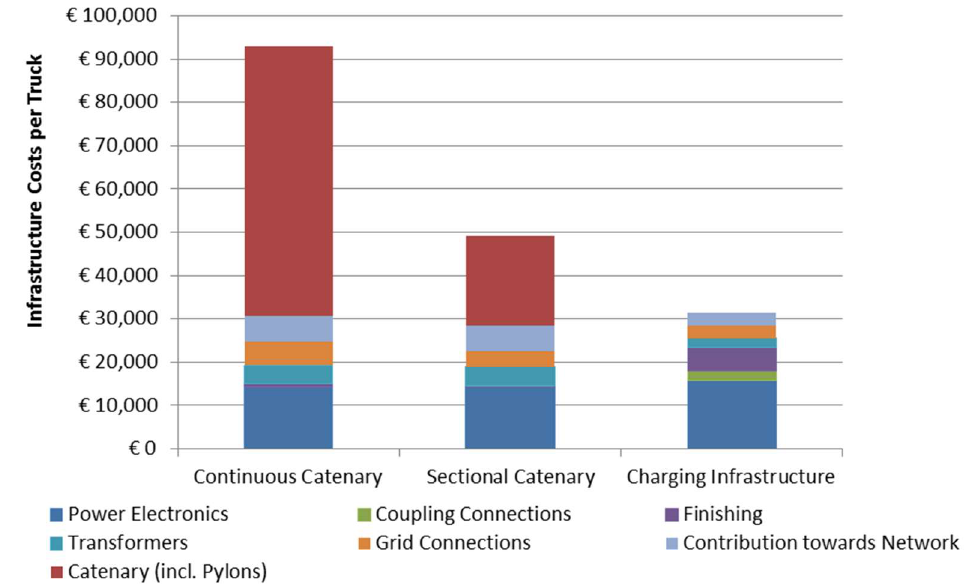
Figure 10. Net present values for catenary infrastructure and charging infrastructure per one truck in the specified transportation scenario.